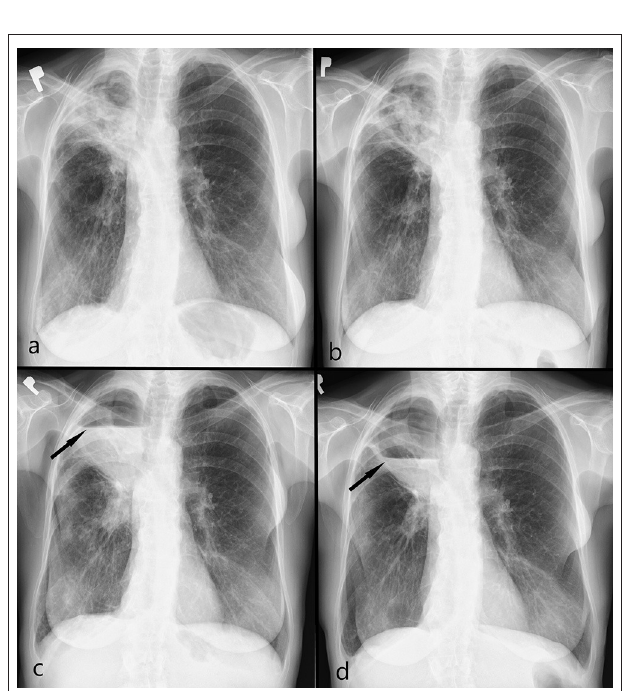
FIGURE 6 | Controlled chest x-ray during second-line treatment in 2021: (a) at the beginning of the therapy - a thick-walled cavity in apical parts of the right lung, progression internal consolidations and surrounding opacities; (b) after 3 months – cavity consolidation, regression of surrounding opacities; (c) after 4 months – cystic lesion with an air-fluid level (arrow) (progression, abscess); (d) after 5 months – regression of an air-fluid level